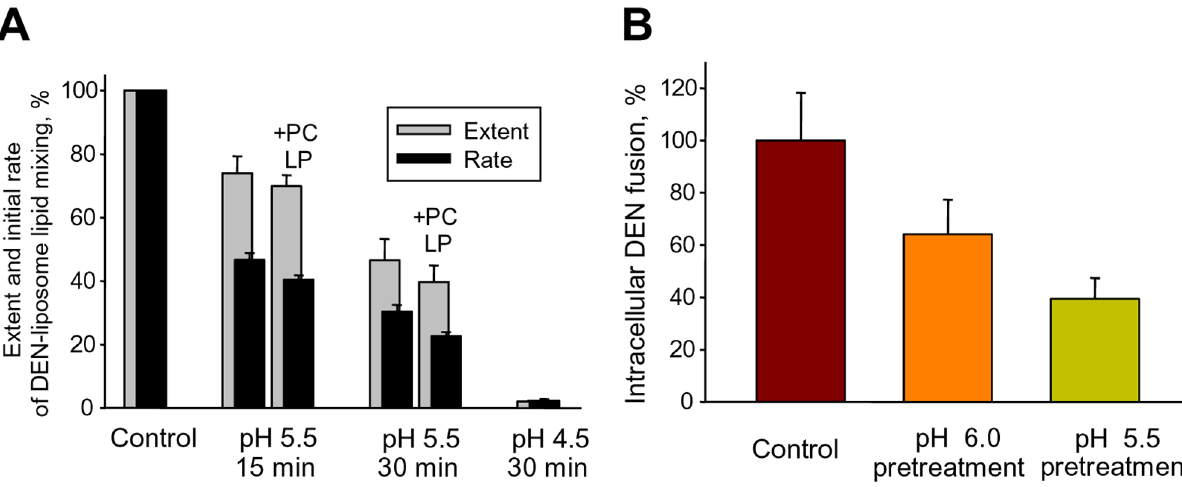
Figure 5. Slow inactivation of fusion machinery of DEN virions acidified in the absence of AL-containing membranes. A. DiD-labeled DEN virions were pre-incubated at pH 5.5 for 15 or 30 min in the absence of liposomes or in the presence of PC liposomes ( + PC LP); or at pH 4.5 for 30 min in the absence of liposomes. After low pH pre-treatment, virions without re-neutralization were mixed with LEM liposomes at pH 5.5. The initial rates of lipid mixing (black bars) and the extents of lipid mixing at t=10 min (gray bars) were normalized to those between DEN and LEM liposomes observed without low pH-preincubation (Control). B. MA104 cells with pre-bound DiD-labeled DEN were pre-treated or not pre-treated at 37 u C with pH 6.0 or 5.5 medium (15 min, 37 u C). Low pH application was followed by a 40-min incubation in the complete medium at 37 u C. Viral fusion events along the endocytic pathway were detected as an increase in the mean total fluorescence per imaging field. Control – no low pH pre- treatment, taken as 100%. A , B . The data are presented as mean + /- s.d.